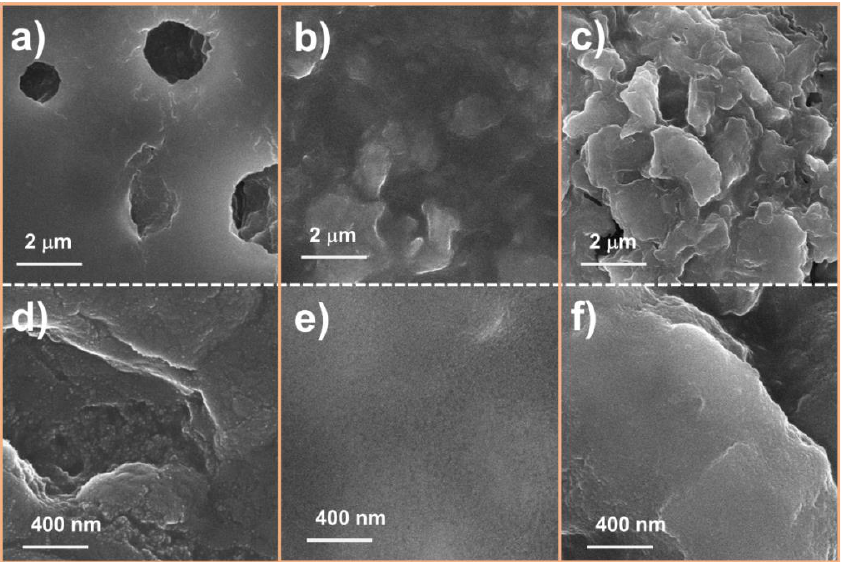
Figure 9. SEM images of ( a , d ) SnO 2 electrode, ( b , e ) M1SnO 2 electrode and ( c , f ) M3SnO 2 electrode after 10 cycles at different magnifications.